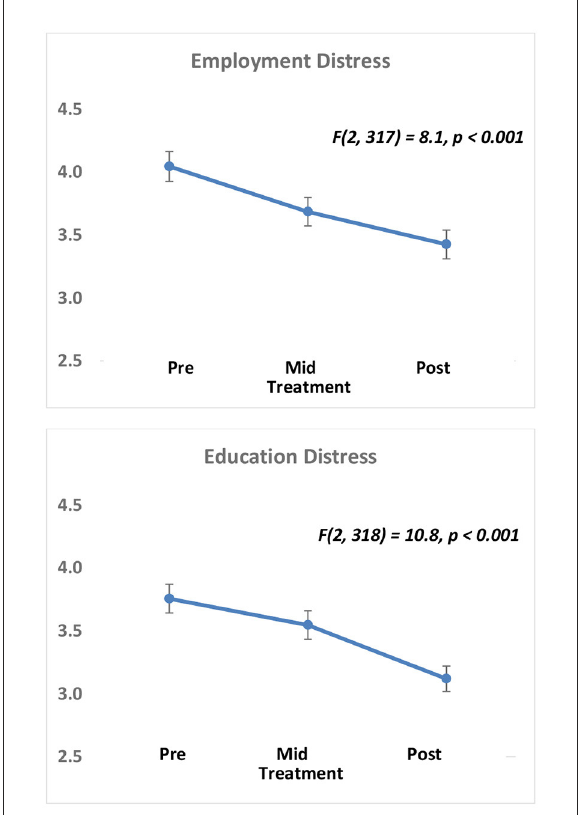
FIGURE1 Improvement in employment and education-related distress across all Roca participants. Participants have significant reductions in Employment Distress (top) and Education Distress (bottom) across the three time points (Pre (intake), Mid (first skills-based appointment), and Post (most recent skills-based appointment) measured in this study. Distress is on a 1–5 scale (5 = most distress), plots show mean +